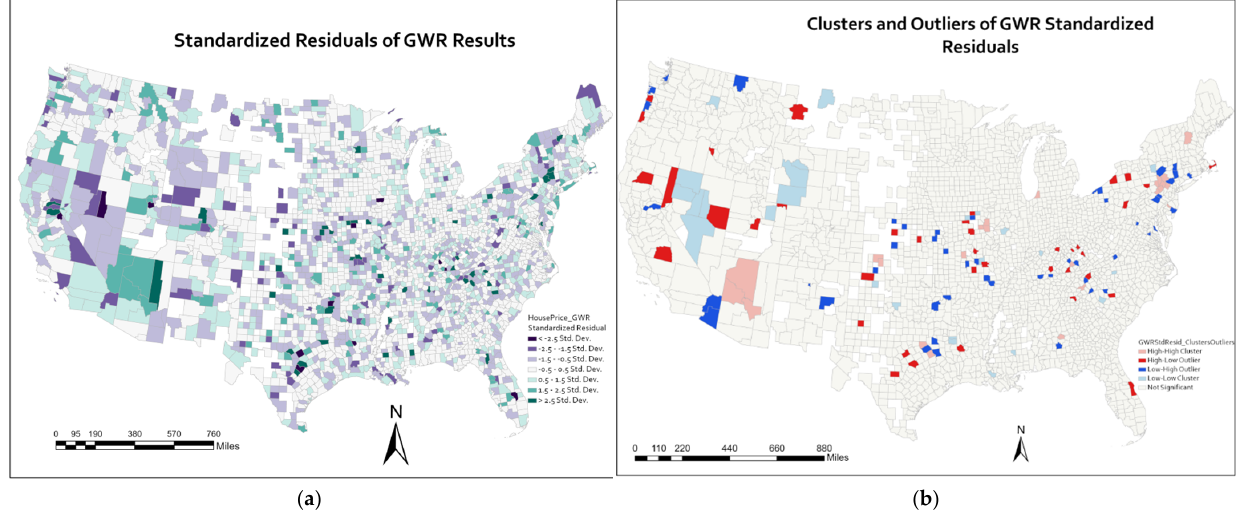
Figure 9. Spatial autocorrelation assessment results of the geographically weighted regression (GWR) residuals. ( a ) Standardized residuals of the GWR results; ( b ) clusters and outliers of the GWR standardized residuals.